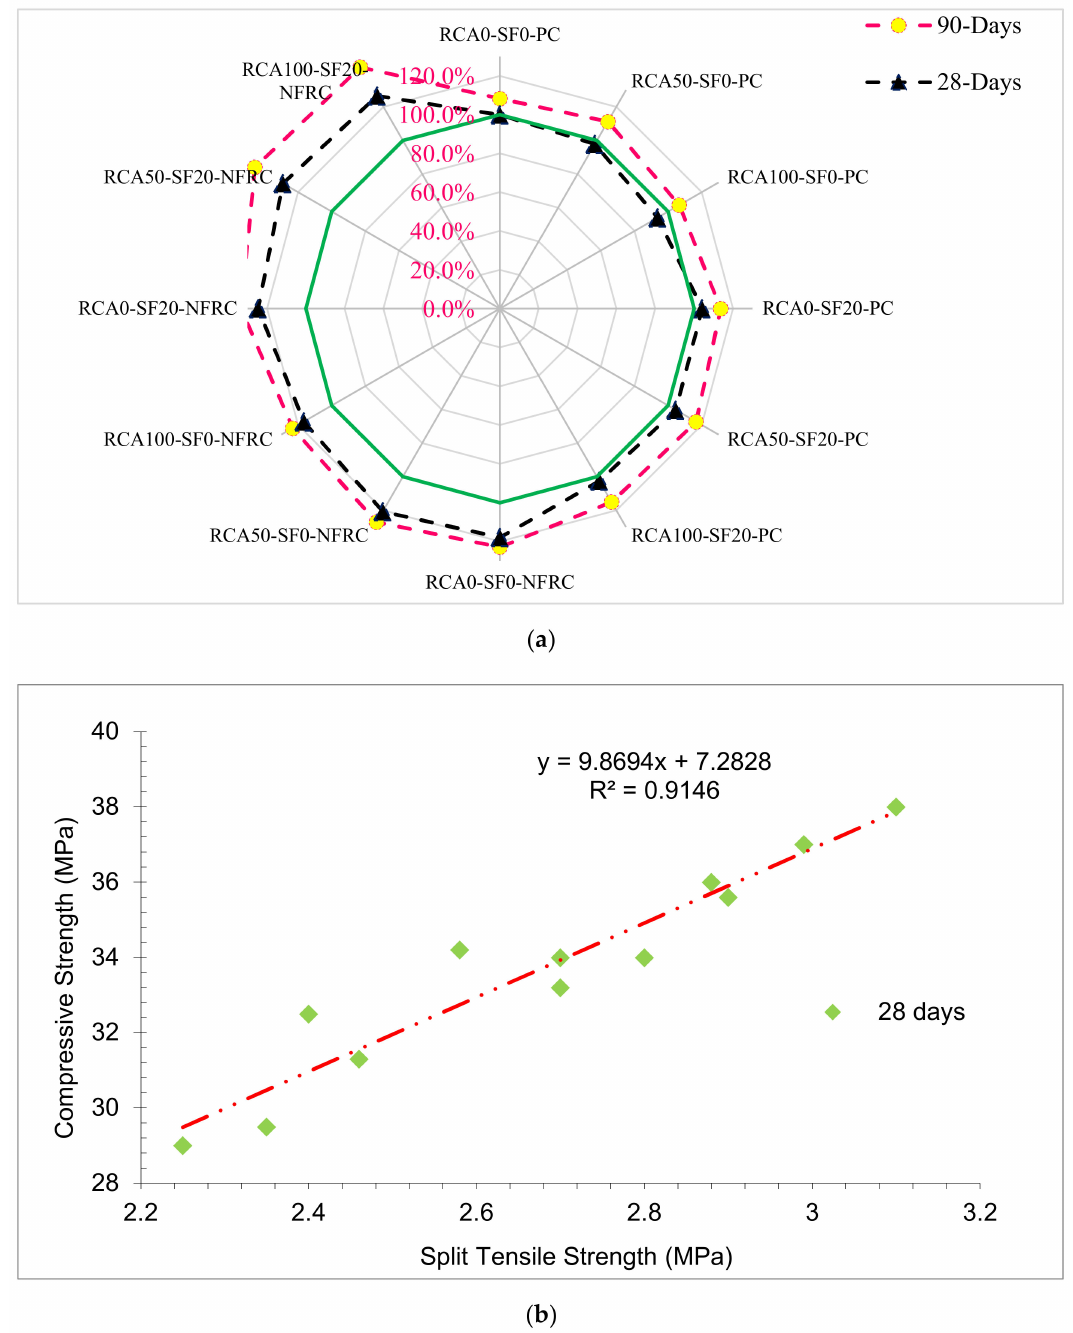
Figure 4. ( a ) Relative Analysis of Split Tensile Strength, ( b ) Correlation between Compressive and Split Tensile